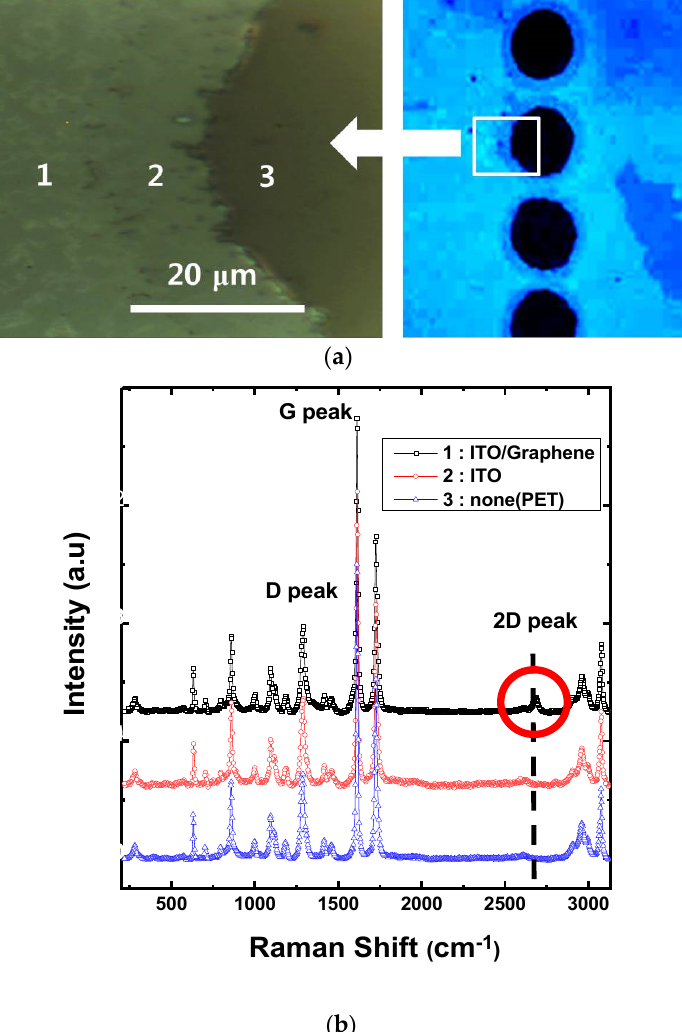
Figure 7. ( a ) Expanded optical microscopy images of Figure 4a. The graphene/ITO double layer was laser ablated at a pulse energy of 266.5 μ J with a scanning speed of 2000 mm/s; ( b ) Raman spectra on regions 1, 2, and 3 of ( a ).